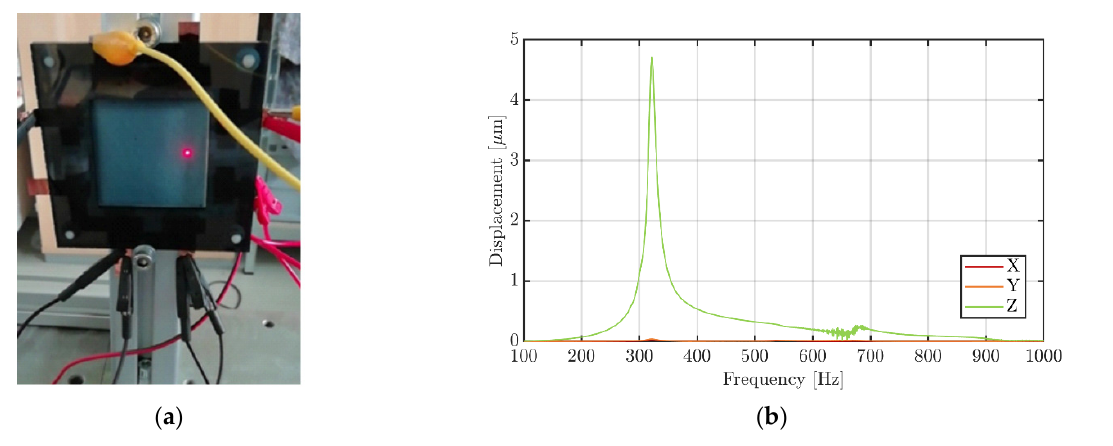
Figure 4. ( a ) Printed multilayer transducer mounted in a plastic frame during 3D laser vibrometer measurement; ( b ) Transfer function of the five-layer multilayer transducer.